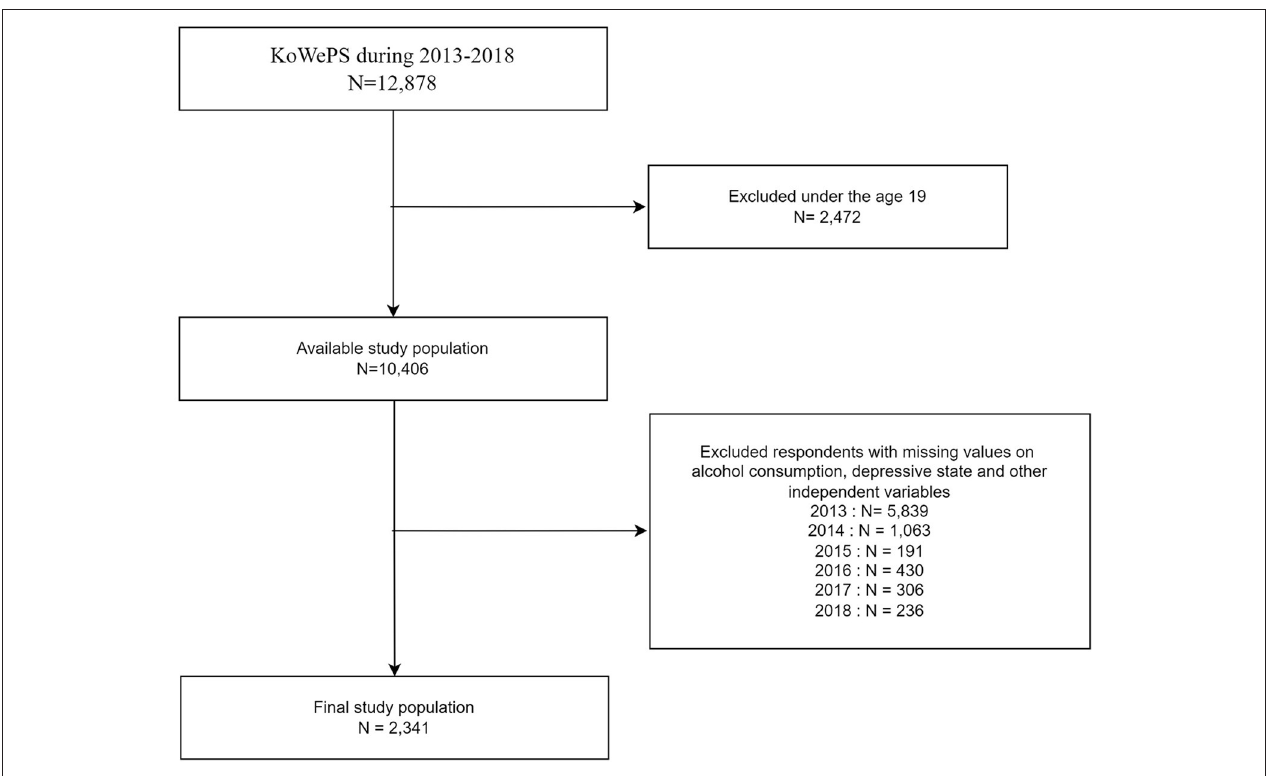
FIGURE 1 | Flow diagram displaying the inclusion and exclusion of